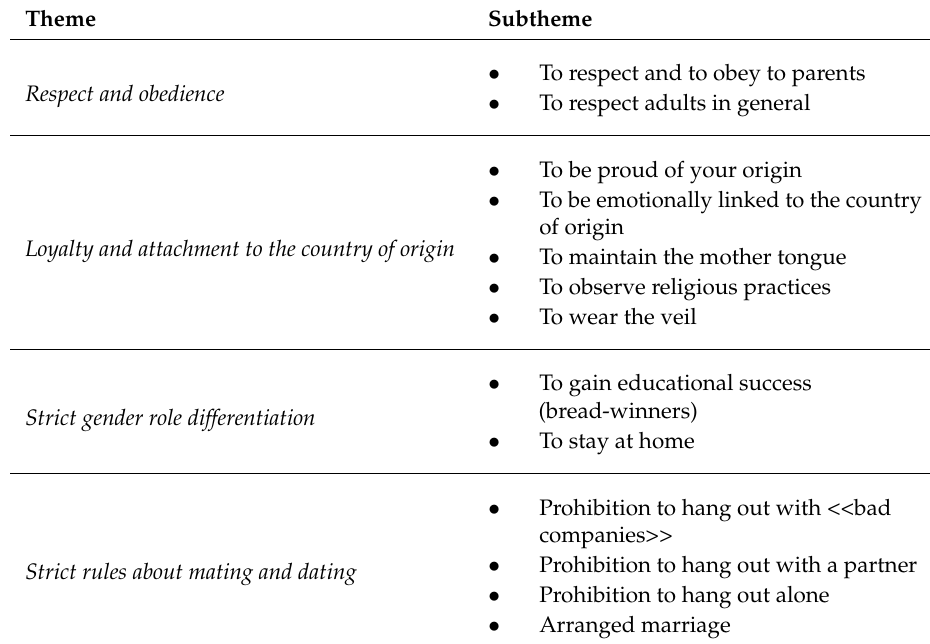
Table 2. Summary of Themes and Subthemes that emerged from Thematic